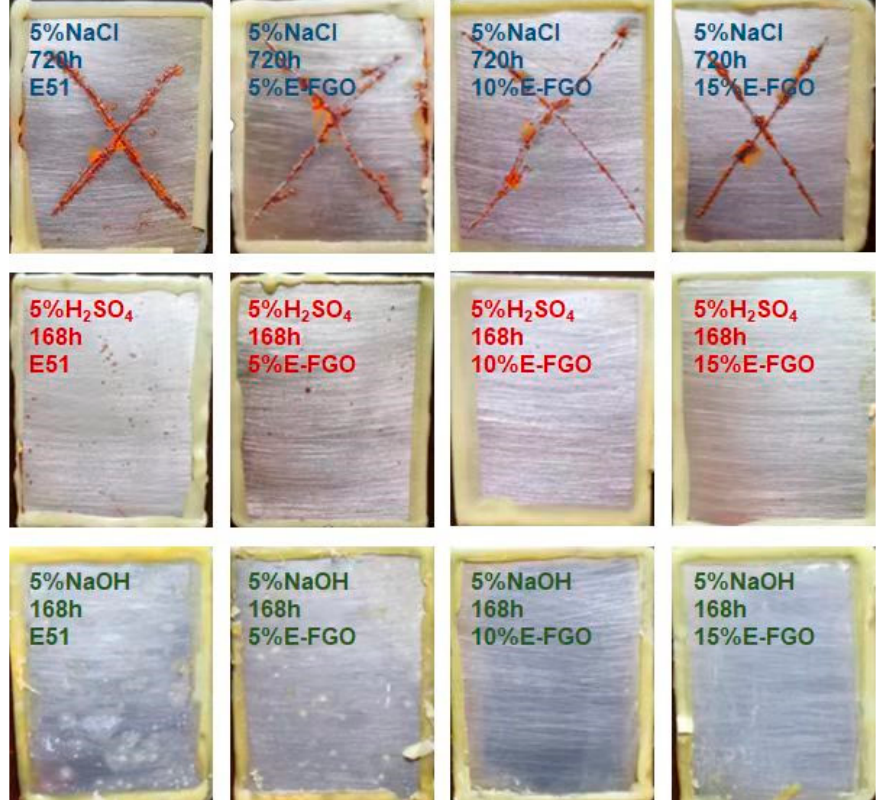
Figure 8. Salt-spray resistance, acid, and alkali resistance tests of E51 and different concentrations of E-FGO coatings.